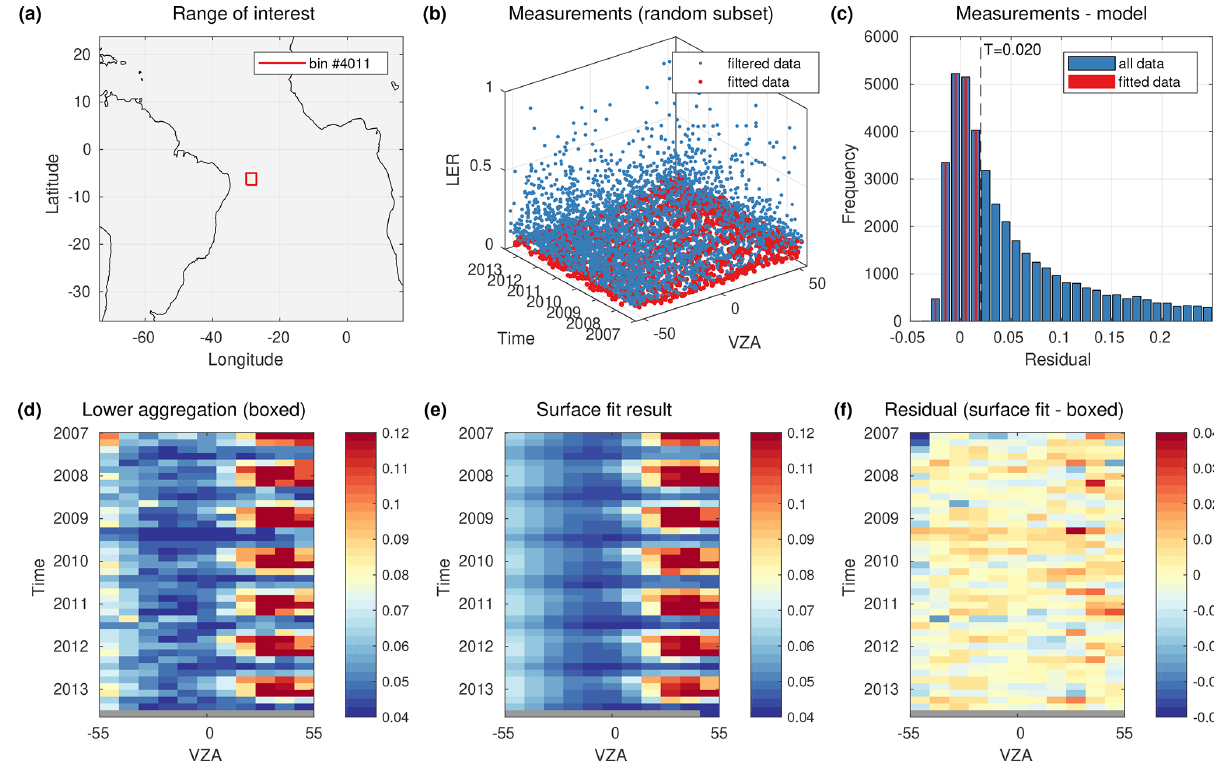
Figure 9. Same as Fig. 8 but for MSC channel 10 at 516.7nm and applying binning no. 5 over the equatorial Atlantic. The set of measurements ranges from 30 ◦ W to 27 ◦ E and from 7.55 to 5 ◦